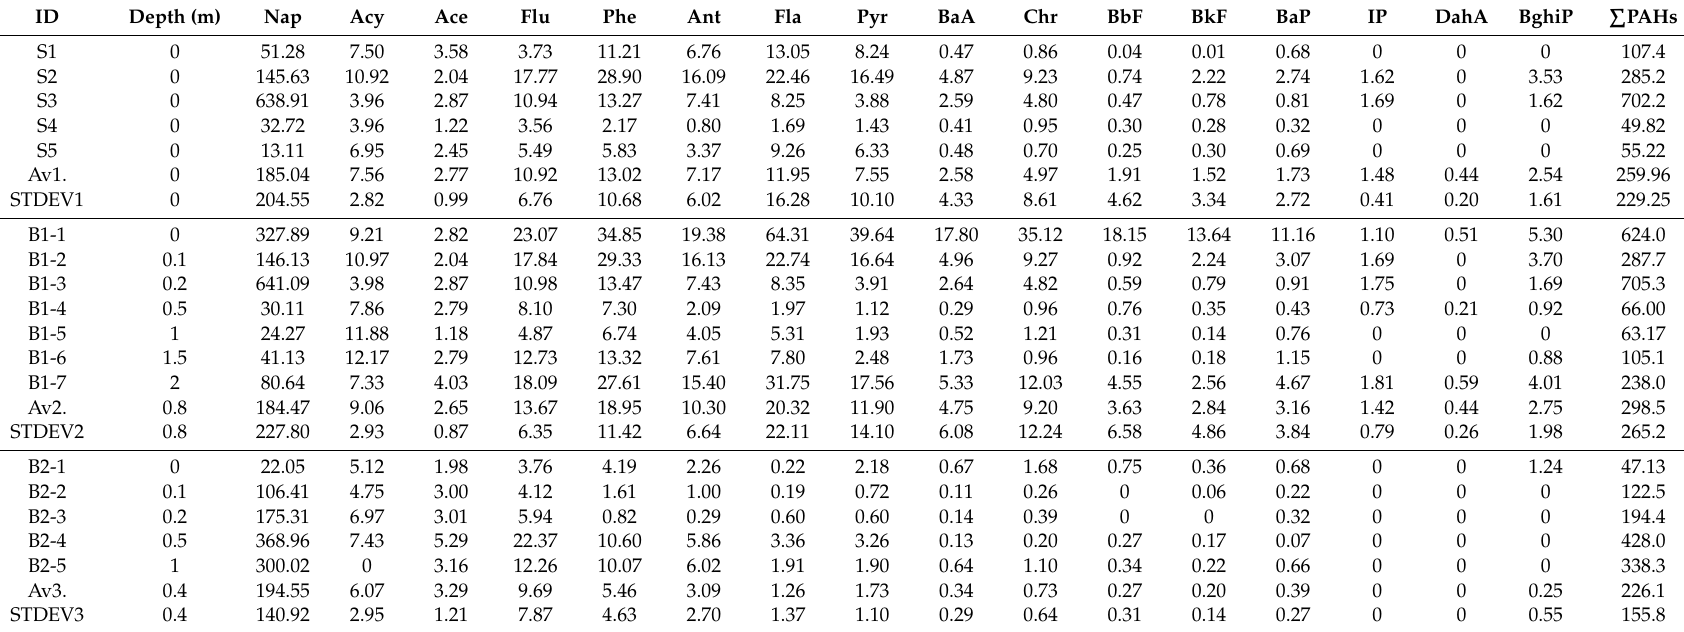
Table 3. PAHs content in soil samples collected around the coal spoil piles (ng / g, dry